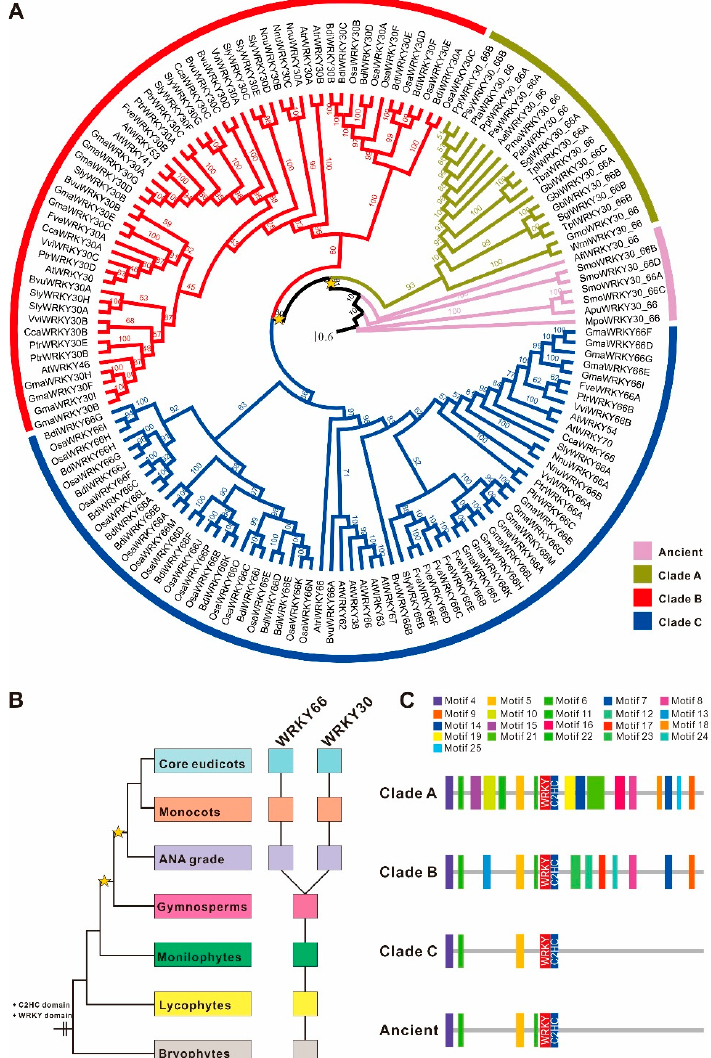
Figure 1. Phylogeny and domain architecture of the WRKY66 homologs in land plants. ( A ) Phylogenetic tree of 145 WRKY66 homologs identified from diverse land plants through maximum-likelihood analyses was conducted using the JTT+I+G+F model. The yellow star indicated the large-scale duplication events. Support values were shown for each node. The scale bar indicated the number of changes per site. Different gene lineages were marked with different colors. Duplication history ( B ) and domain architecture ( C ) of the WRKY66 homologs. Filled squares indicate the presence of the corresponding members. The color of squares corresponds to the left organismal tree. The yellow stars in the tree indicated whole-genome duplication events. The diagram on the right demonstrated the domain/motif composition of different duplicates. The known conserved domains/motifs included: WRKY motif and C 2 HC-type zinc finger motif. The unnamed domains/motifs were lineage-specific and marked with the colors corresponding to the sequence logos in Supplementary Figure